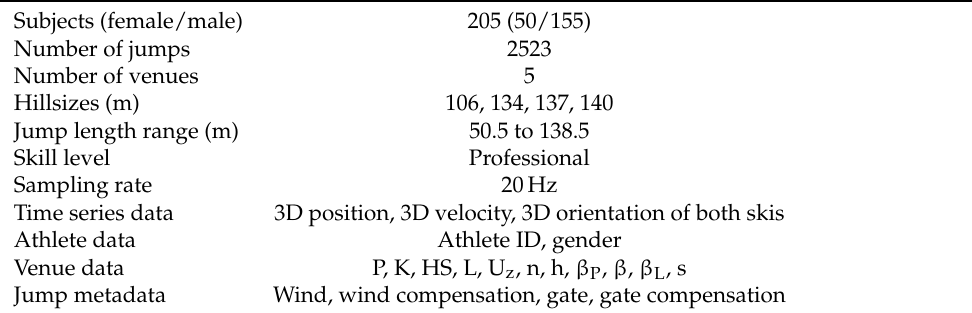
Table 1. Summary of the dataset used in this study. Data were acquired during competition and the training of world-leading athletes. The venue data are named according to the ski jumping hill construction standards of the FIS [34].